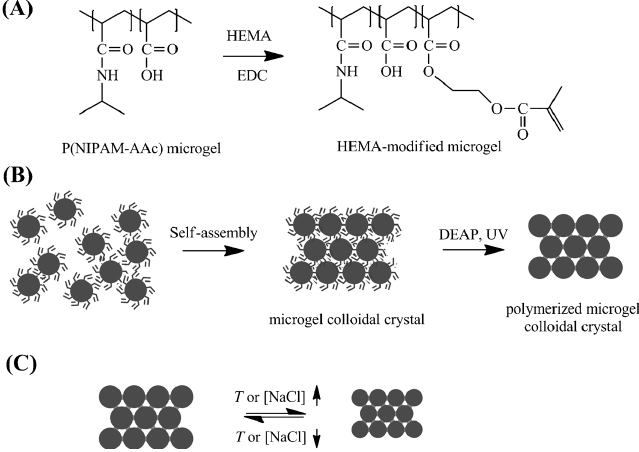
Figure 6. ( A ) Synthesis of HEMA-modified microgels by coupling of P(NIPAm-AAc) microgels with HEMA under catalysis by EDC. ( B ) Synthesis of polymerized microgel colloidal crystals (PMCC). ( C ) Response of PMCC to temperature or salt. Note: HEMA: 2-hydroxyethyl methacrylate; AAc: acrylic acid; EDC: N -(3-dimethyla-minopropyl)- N ’-ethylcarbodiimide hydrochlorid. Reproduced with permission from